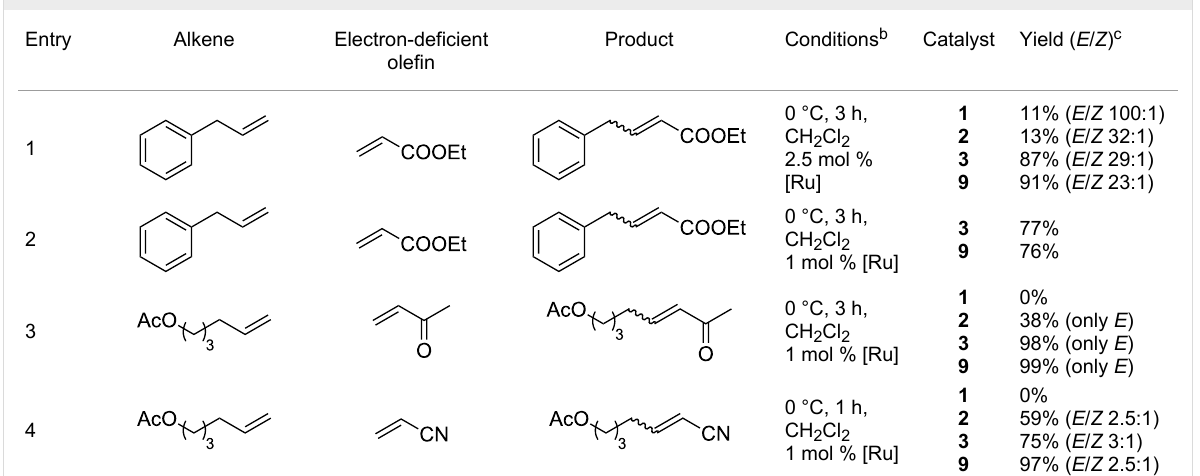
Table 1: Comparative investigation of catalysts in CM reactions with electron-deficient